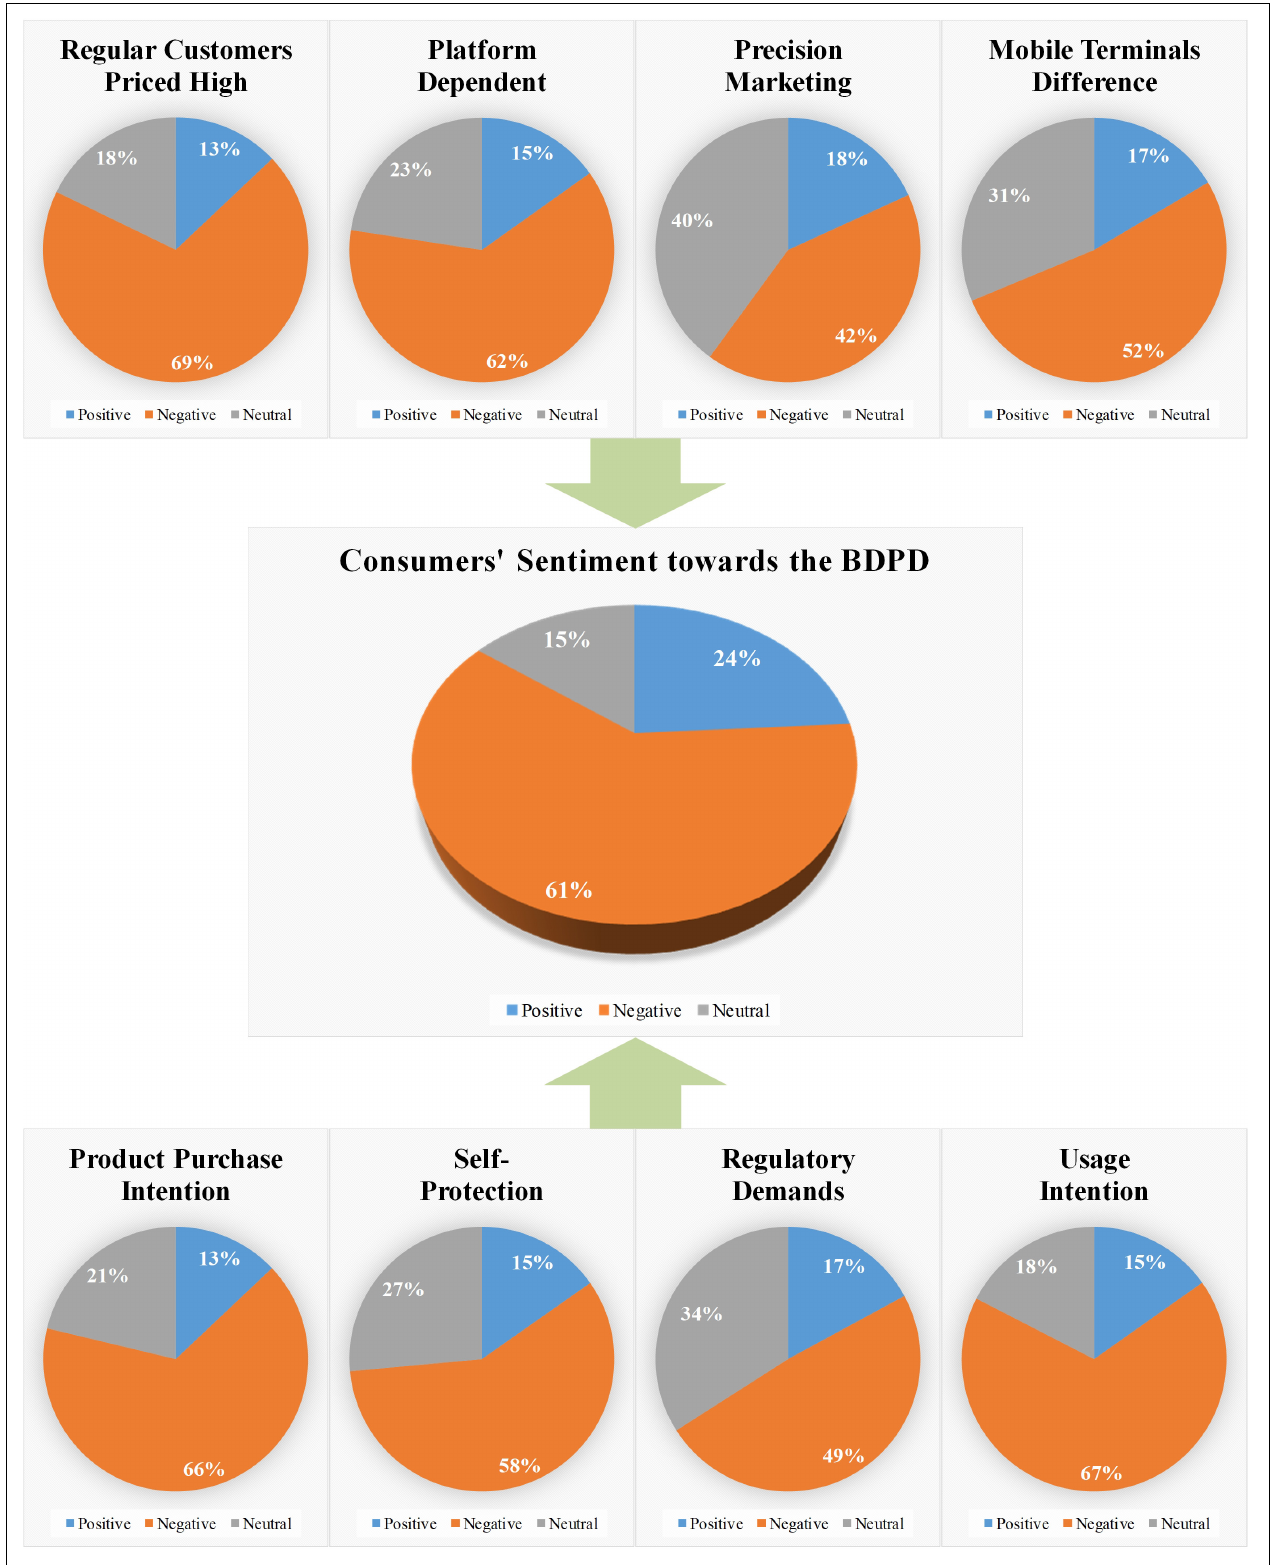
FIGURE 7 | The experiment result of multi-topic sentiment